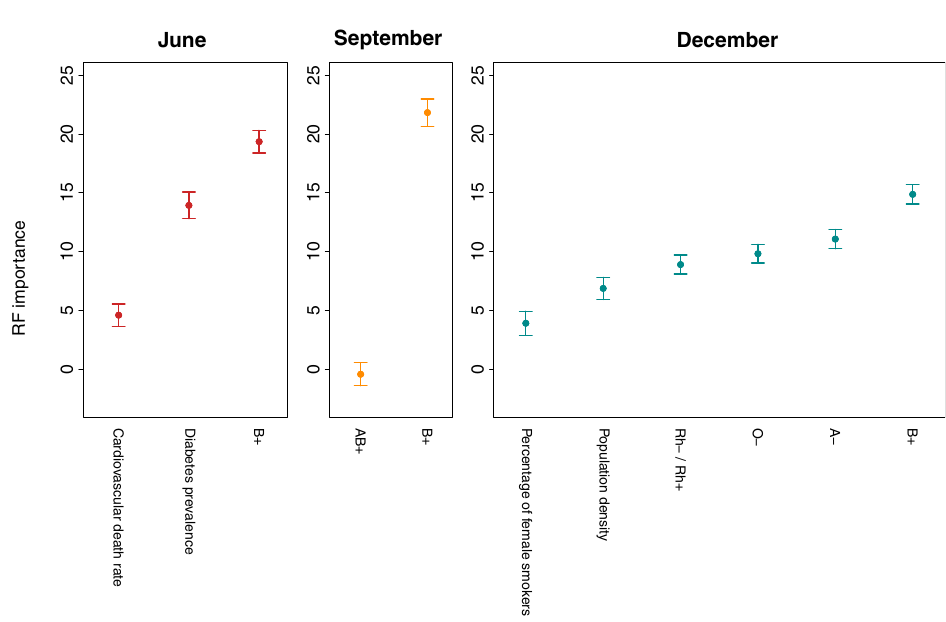
Figure 3. Boxplot of the distribution of the Boruta importance measure for input variables with median higher than variable “Shadow Max”. The distribution was obtained from 500 runs of the algorithm on the complete set of features using June, September, and December 2020 TDPM data. Using as cut-off the upper quartile of “Shadow Max”, we colored in yellow excluded variables and in green variables selected for further analysis. R base package graphics 4.0.5 was used to generate the figure.